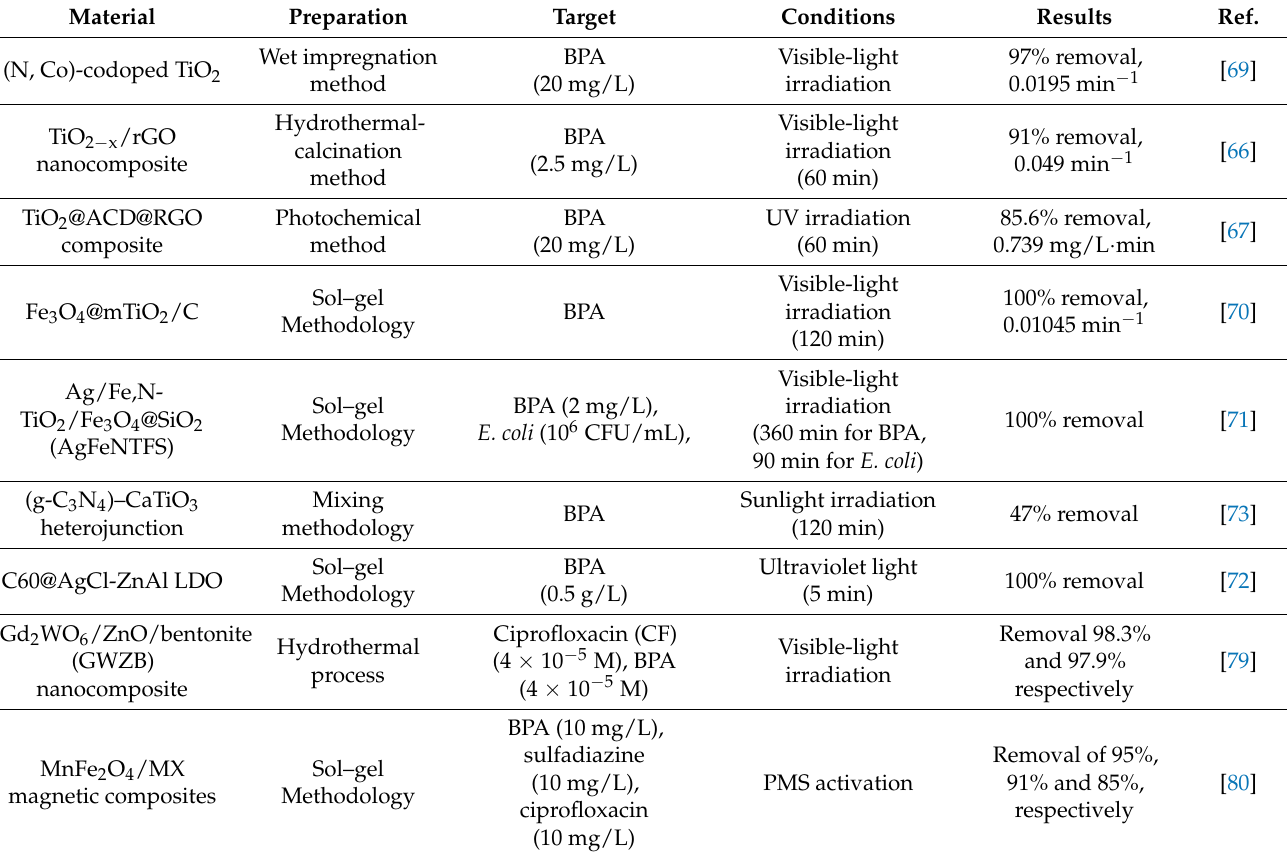
Table 2. Summary of representative metal-oxide-based nanomaterials used for the degradation processes of bisphenols and